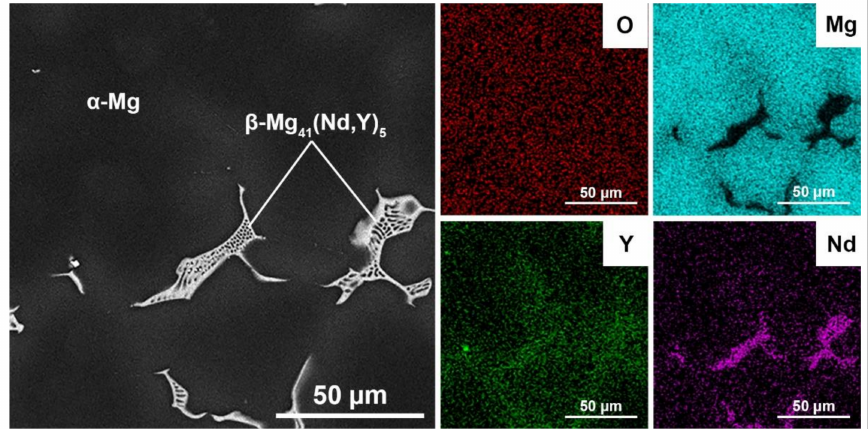
Figure 6. SEM image and EDS maps of elements distribution inside the reference as-cast material.